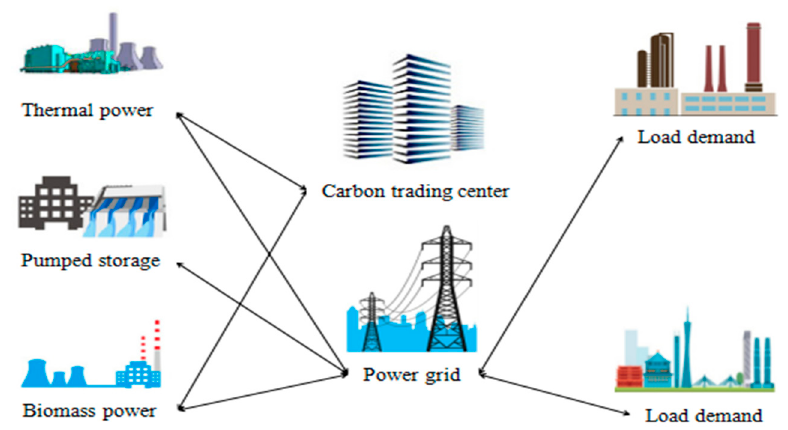
Figure 1. Power generation dispatching system.